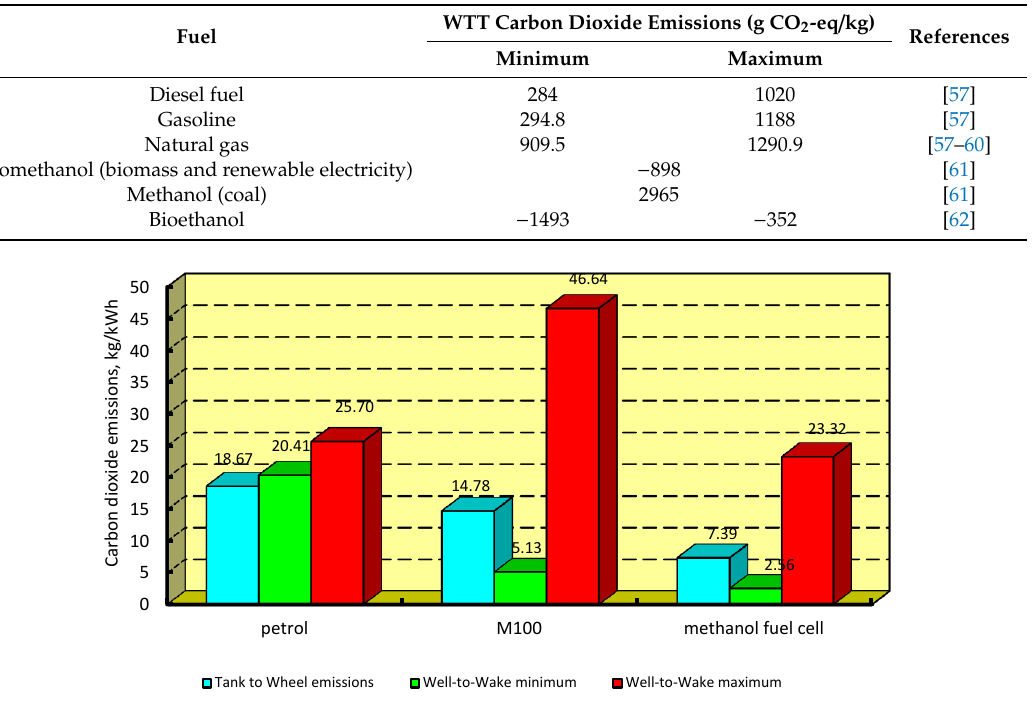
Figure 5. Carbon dioxide emissions per 100 km.